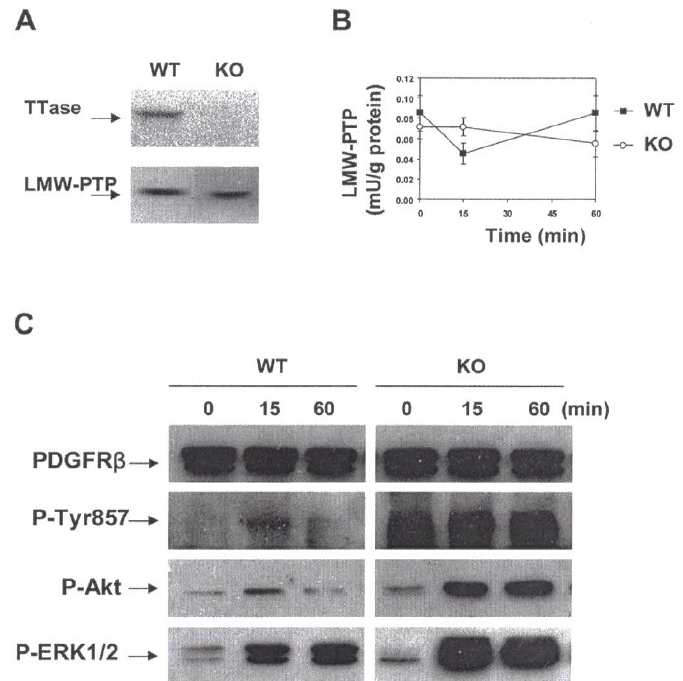
Figure 13. Evidence for the TTase-dependent LMW-PTP function in the mouse lens epithelial cells. ( A ). Immunoblot analysis of TTase and LMW-PTP from wild type (WT) and TTase knock-out (KO) mouse lens epithelial cells. Cell extract containing 30 g protein was resolved on 10% SDS-PAGE gel. TTase and LMW-PTP were probed with respective antibody. ( B ). PDGF-induced inactivation of LMW-PTP in WT ( ◼ ) and KO ( ) mouse lens epithelial cells. Serum-deprived cells were stimulated with PDGF (1 ng/mL) for 0, 15, and 60 min, harvested, lysed and immunoprecipitated for activity assay. Data are expressed as means ± SD, with n = 3. ( C ). Comparison of the PDGF-induced activation of PDGFR β , Akt and ERK 1 / 2 in WT and KO mouse lens epithelial cells. Serum-deprived cells were stimulated with PDGF (1 ng/mL) for 0, 15 and 60 min, harvested and lysed. Cell lysate (50 g proteins) was applied on 10% SDS-PAGE gel, transferred to membrane and probed with antibodies to PDGFRβ (internal control), P - PDGFRβ (Tyr857), P -Akt and P-ERK1/2, respectively. The Western blots shown are the representative of three separate experiments. Reprinted with permission from Xing et al., BBA (2007); Copyright Elsevier 2007 [100].